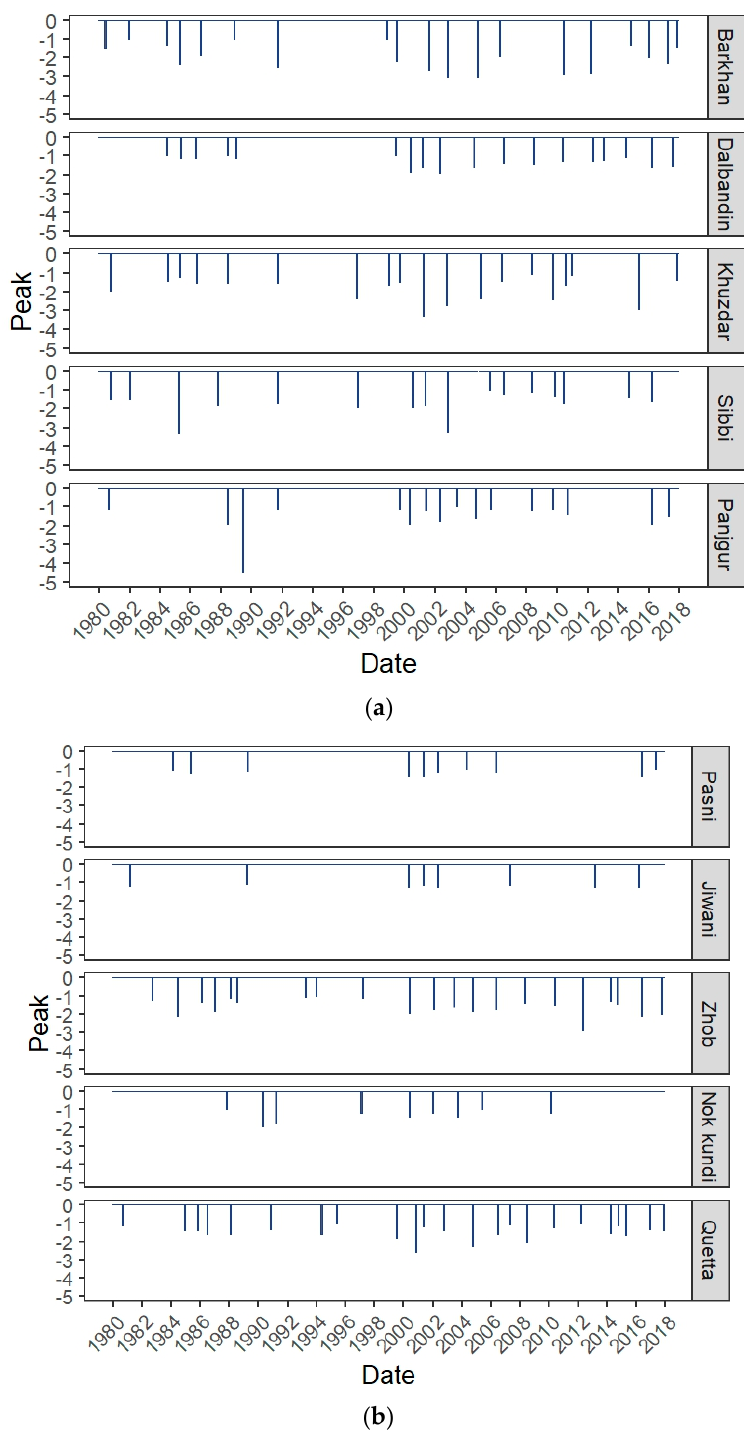
Figure 15. Drought peaks at all stations.